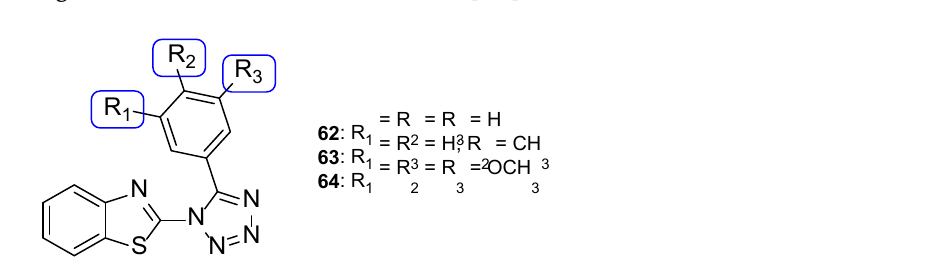
Figure 32. Chemical structures of 60 and 61 [112]. Benzothiazole-tetrazole hybrids were synthesized by Shanmugapandiyan and At- makuru to assay their antifungal activity against two fungal strains, A. niger and C. albi-